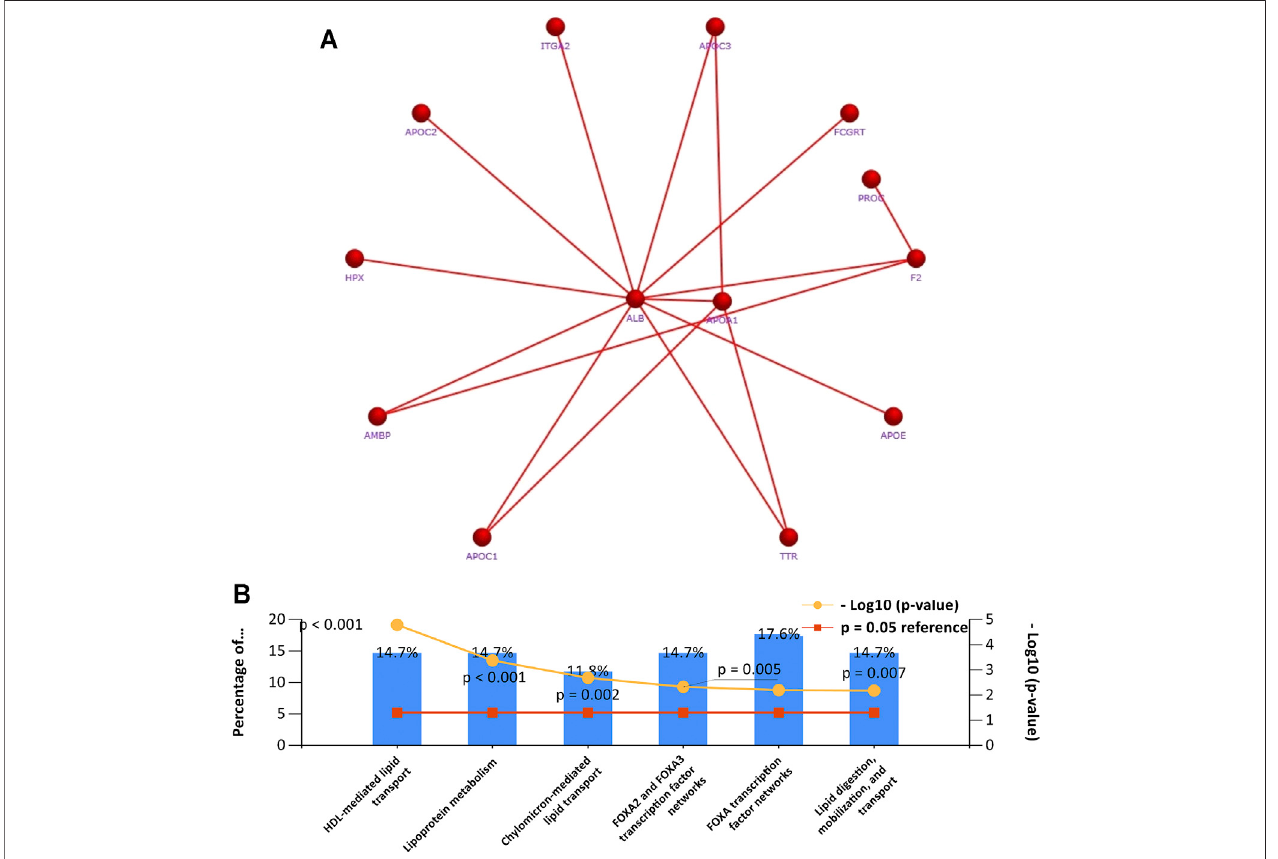
FIGURE 8 | Gene set enrichment analysis of PCR-array. (A) The network of APOA-1 and its co-expressed genes in various cells; (B) gene set enrichment analysis of biological processes.